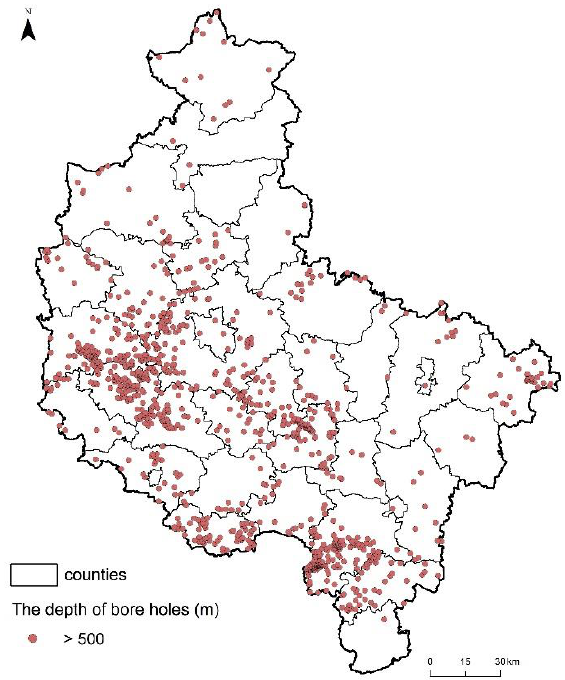
Figure 14. The bore holes of a minimum depth of 500 m in the Greater Poland Voivodeship (own study from [97]).